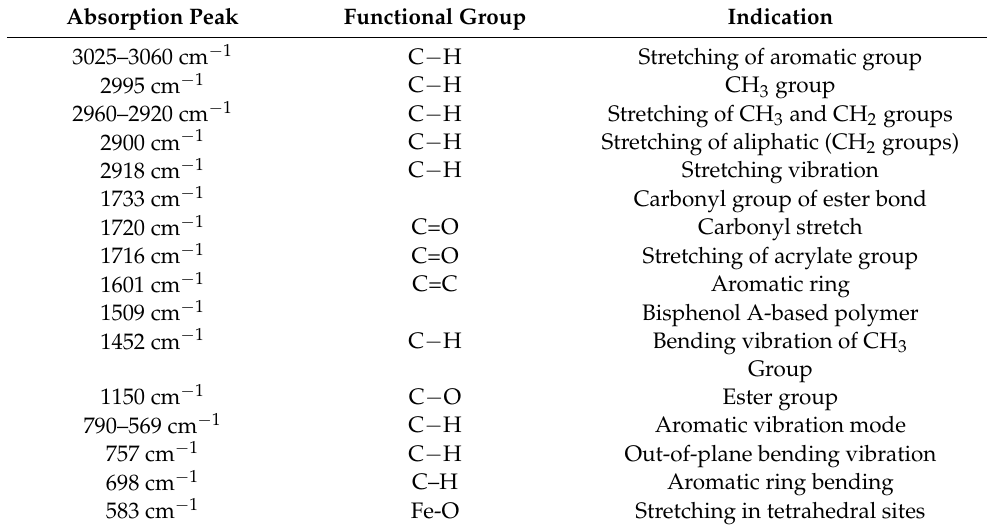
Table 3. Common absorption peaks of waste